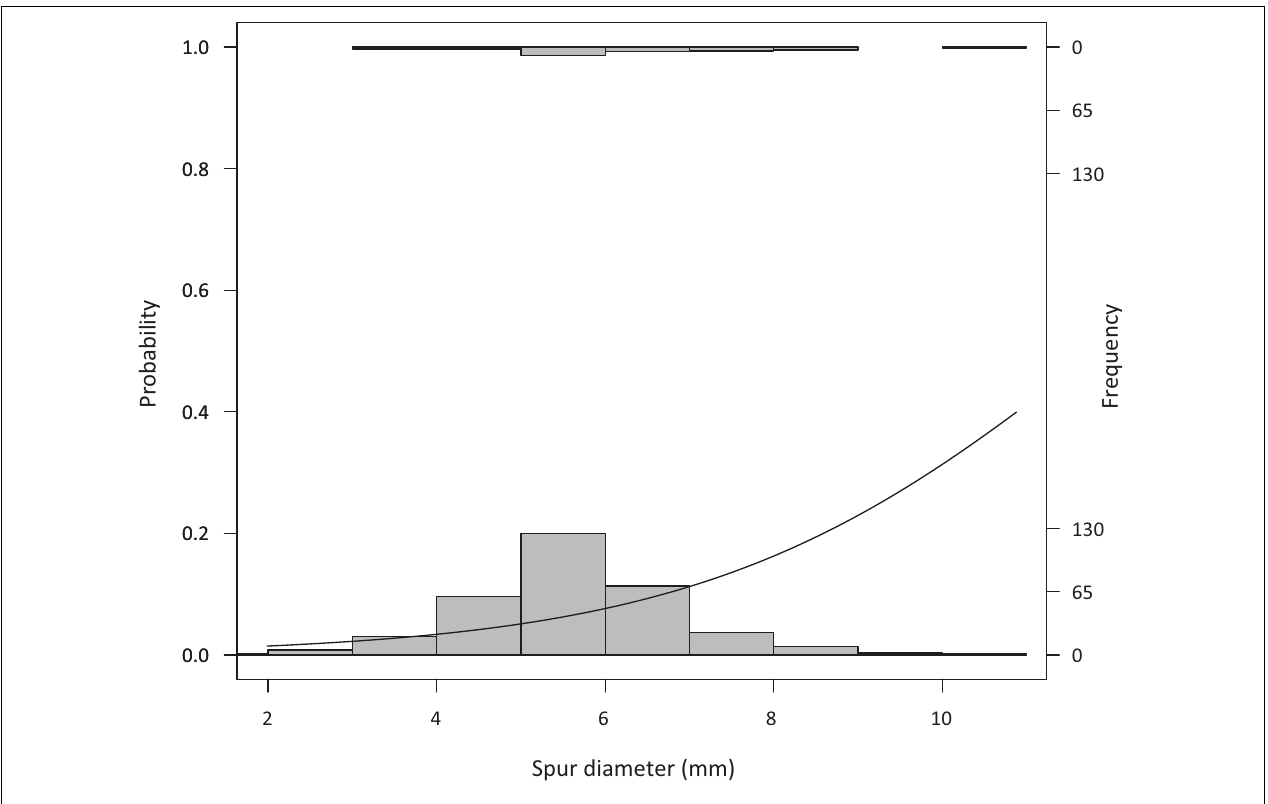
FIGURE 2 | Spur diameter in greenhouse-grown vines (measured when plants were removed from dormancy) related to the probability that a plant would reach 50% flowering ( Z (340) = 2.85, p = 0.004), with larger spur vines more often reaching 50% flowering. Histograms show the vines that did not reach 50% flowering (recorded in this analysis as 0 values, bottom) and those that did reach 50% flowering (recorded in this analysis as 1 values, top).